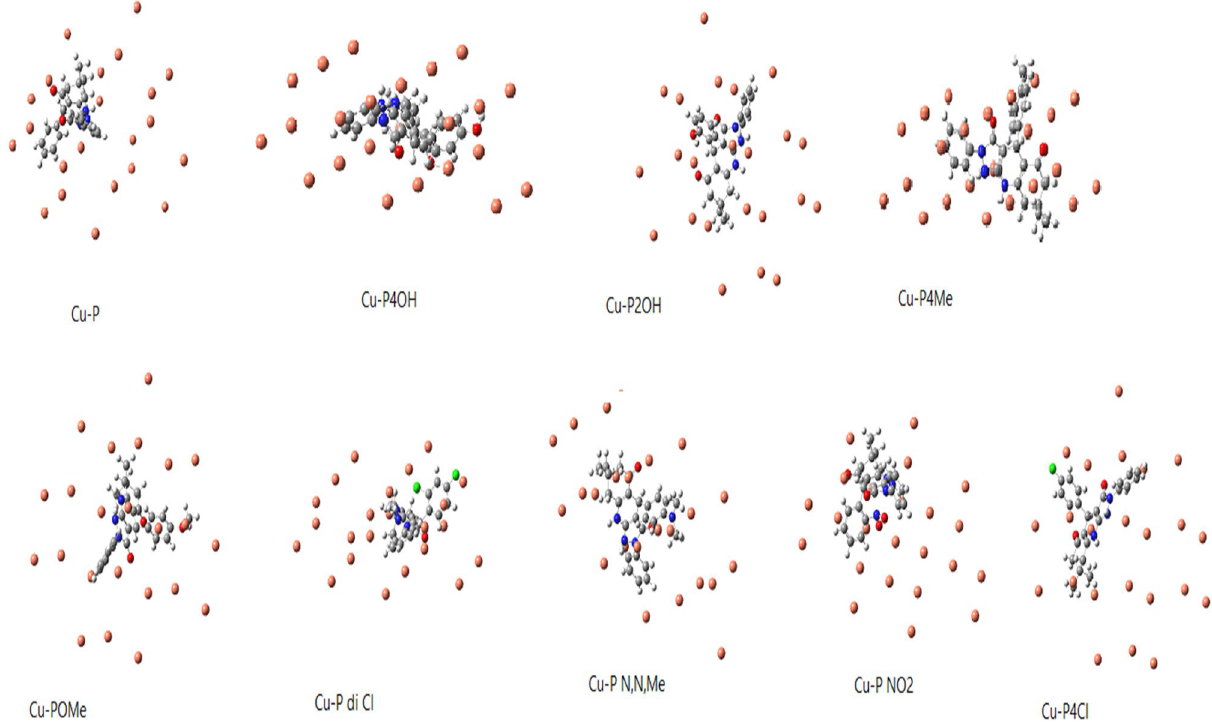
Figure 4. Optimized simulated Cu-Complexes of pyrazoloquinolines derivatives (https:// chemi stry. com. pk/ softw are/ free- downl oad- chemd raw- ultra- 12/, https:// gauss view. softw are. infor mer. com/5.